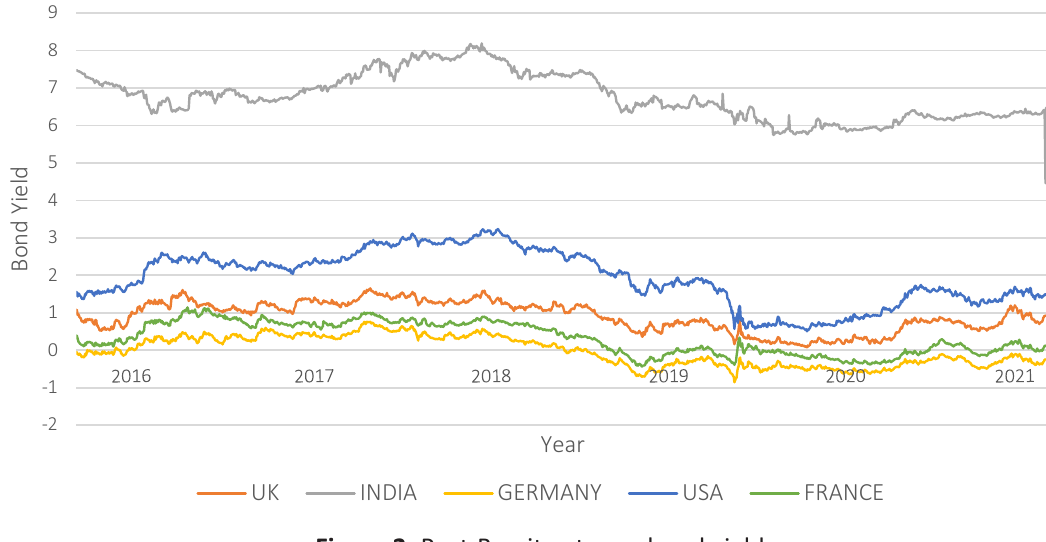
Figure 2. Post-Brexit vote era bond Table 2. Correlation matrix between bond yields at first difference